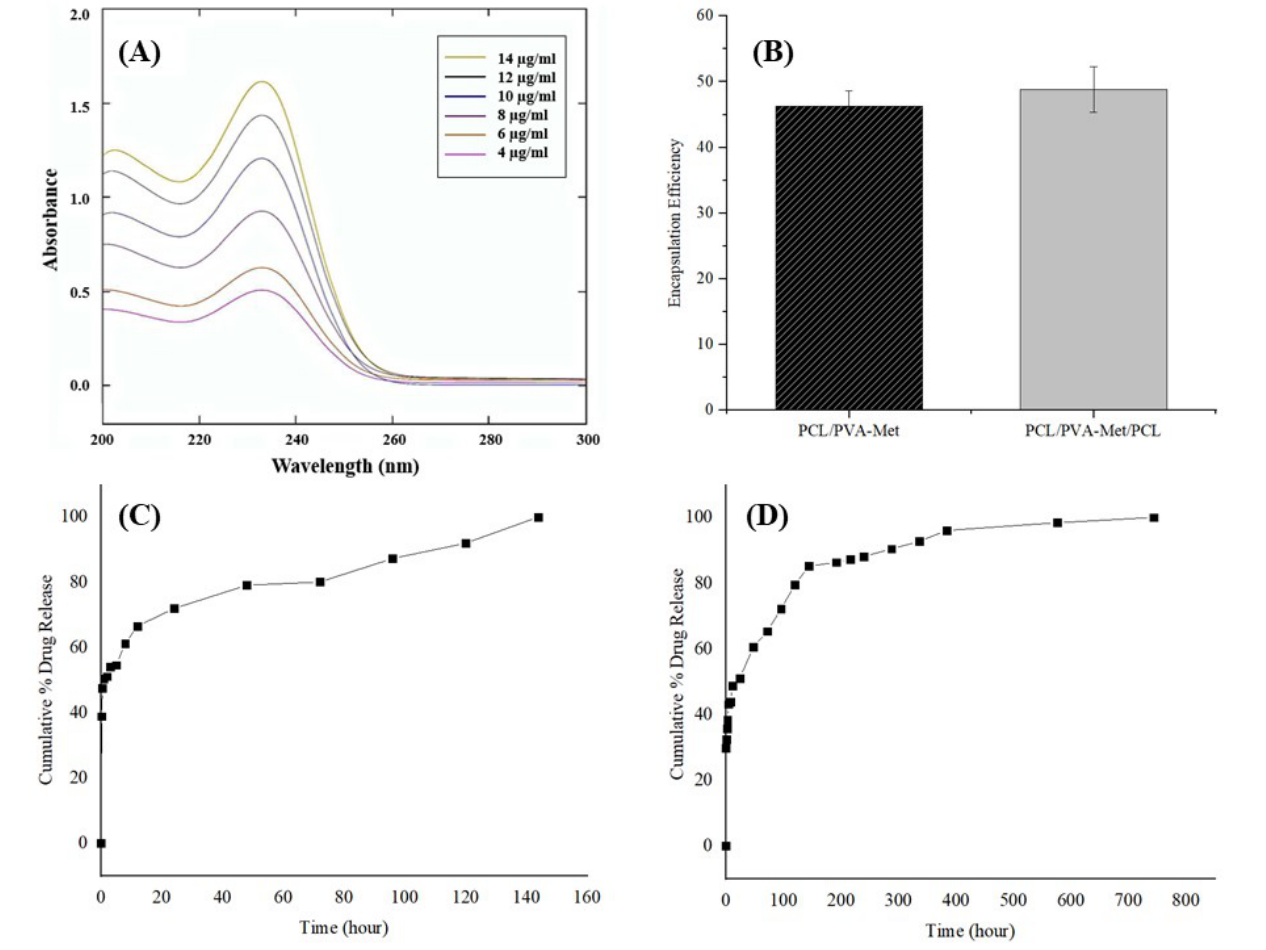
Figure 5. In vitro drug release of scaffolds: ( A ) Absorption spectra of metformin at 6 different concentrations, ( B ) encapsulation efficiency of the scaffolds, ( C ) release profiles of metformin from PCL/PVA-Met and ( D ) PCL/PVA-Met/PCL scaffolds.